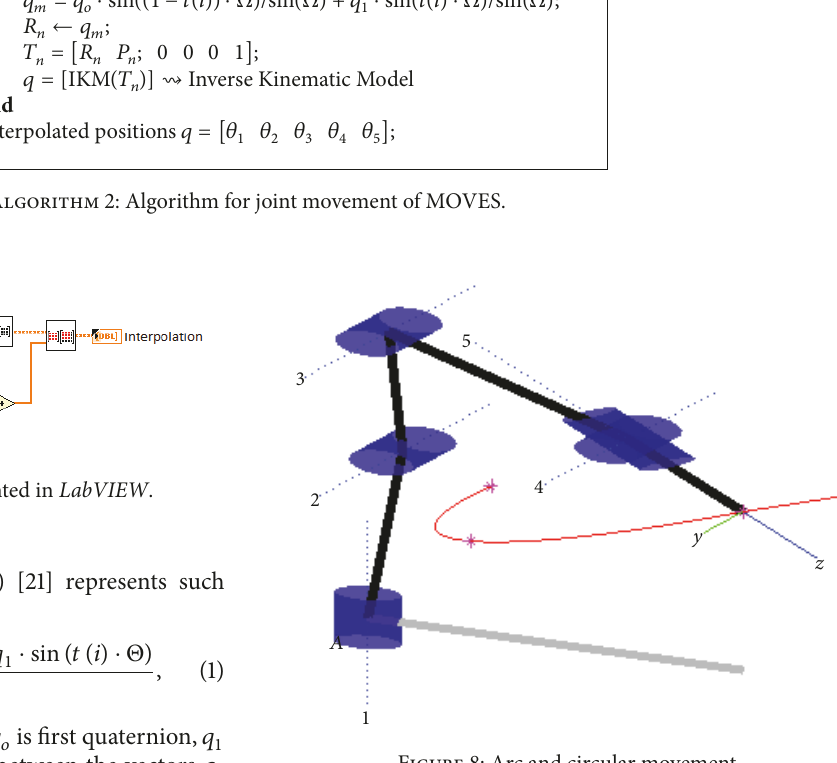
Figure 8: Arc and circular